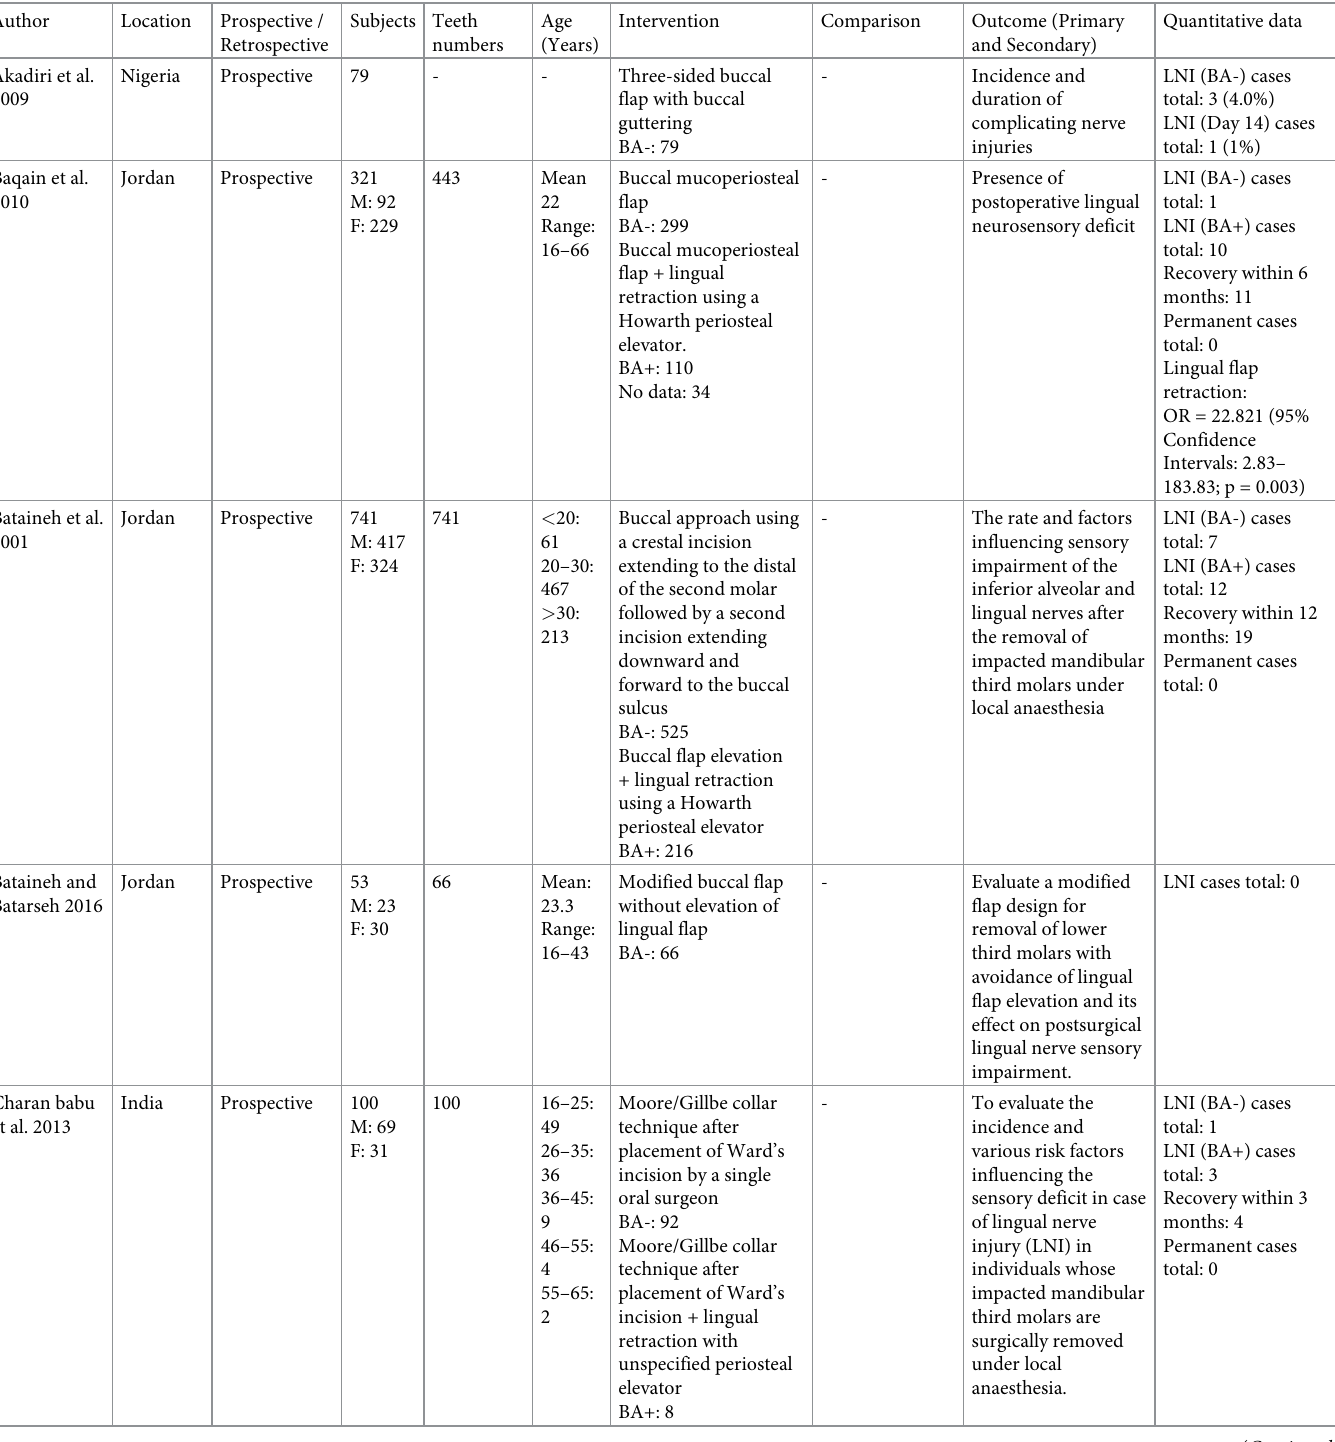
Table 1. Characteristics of the studies which utilised BA-, BA+ and LS